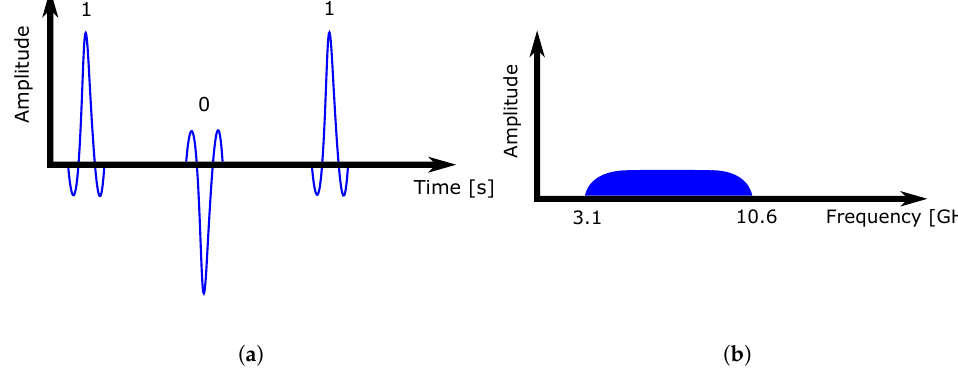
Figure 2. UWB communication pulses. ( a ) Time–domain behaviour. ( b ) Frequency–domain be-